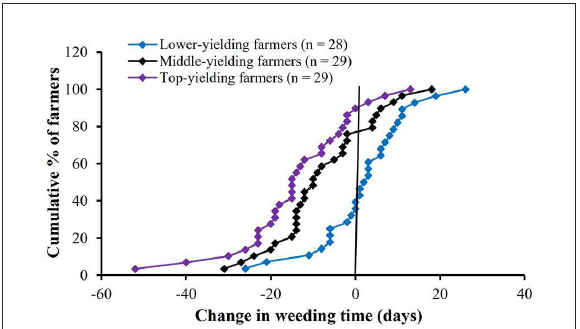
FIGURE2 Change in weeding time by farmers after joint experimentation, Doho 2021. Change in weeding time was calculated as the difference between weeding time in FP plot during (2019) and after (2021) joint experimentation, days after transplanting (DAT). Minus (–) value implies that weeding time after experimentation was later compared with weeding time in FP plot during experimentation.